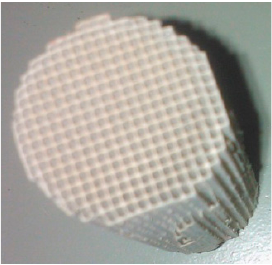
Figure 1. Reforming catalyst.